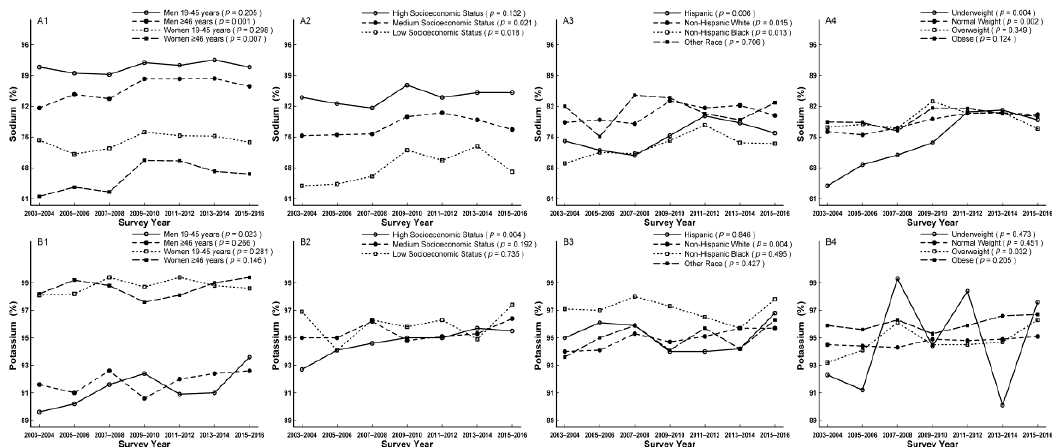
Figure 3. Trends of dietary sodium(A1 – A4) and potassium (B1–B4) by sex, age, socioeconomic